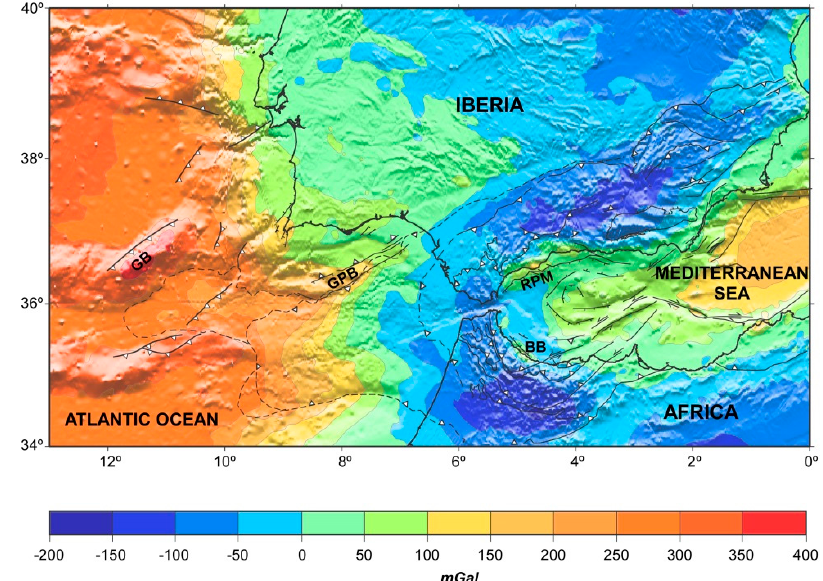
Figure 2. Bouguer gravity anomaly map of the Iberia–Africa plate boundary region. Tectonic background as in Figure 1. GB: Gorringe Bank; GPB: Guadalquivir–Portimao Bank; RPM: Ronda Peridotite Massif; BB: Beni–Bousera peridotites.